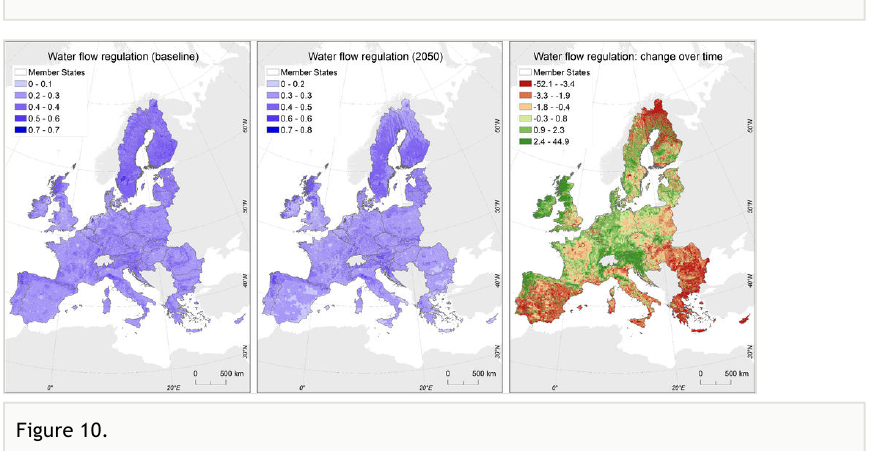
Figure 10. Water fl ow regulation for the baseline, the 2050 and as a percent change over time (2050 vs. baseline). For the baseline and the 2050 maps, classes represent equal intervals over the range of rendered predictions; for the percent change over time, the visual representation re fl ects the distribution of the values. Maps are displayed using the Projected Reference System LAEA. See main text for additional